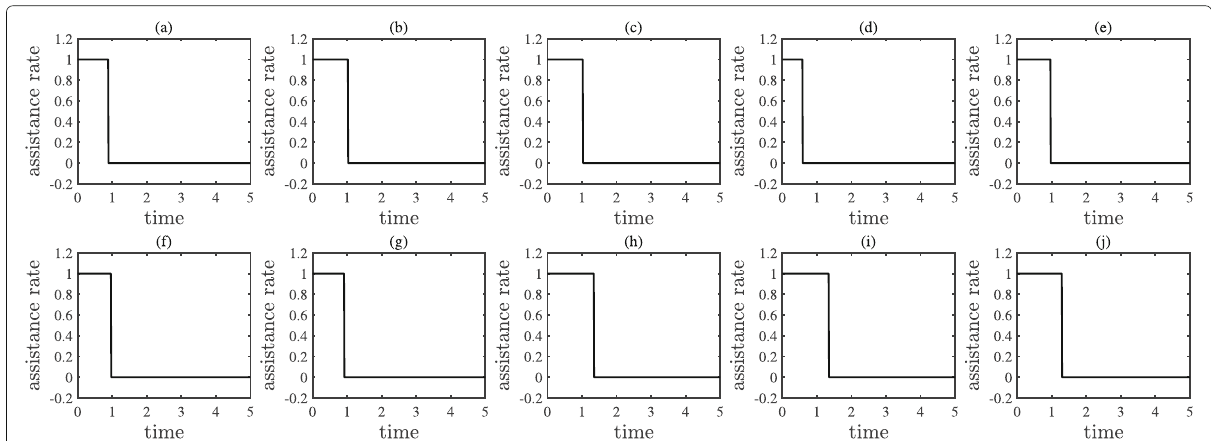
Fig. 8 The optimal policy obtained from Example 2, where ( a ) to ( j ) show the elements u 1 ( t ) , u 2 ( t ) , ... , u 10 ( t ) in order